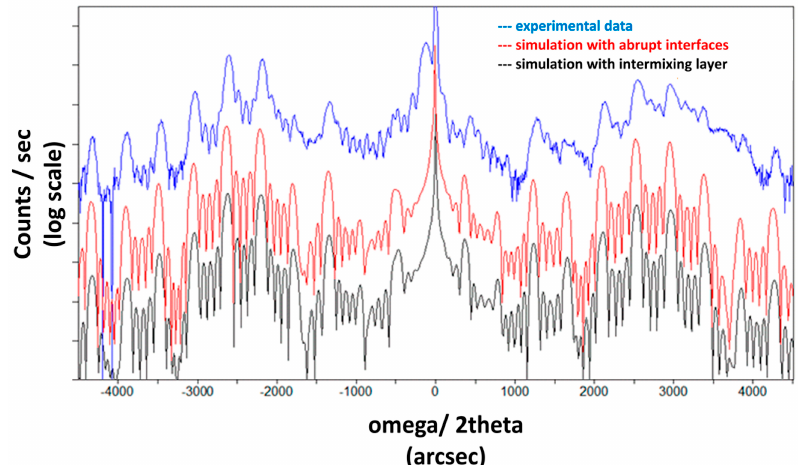
Figure 2. High-resolution X-ray diffraction (HRXRD) (004) ω -2 θ scan for the thick-motif SL with simulations: (red) abrupt SL interfaces and (black) SL with a 1 nm thick constant composition intermixing layer. All scans are offset vertically for clarity.